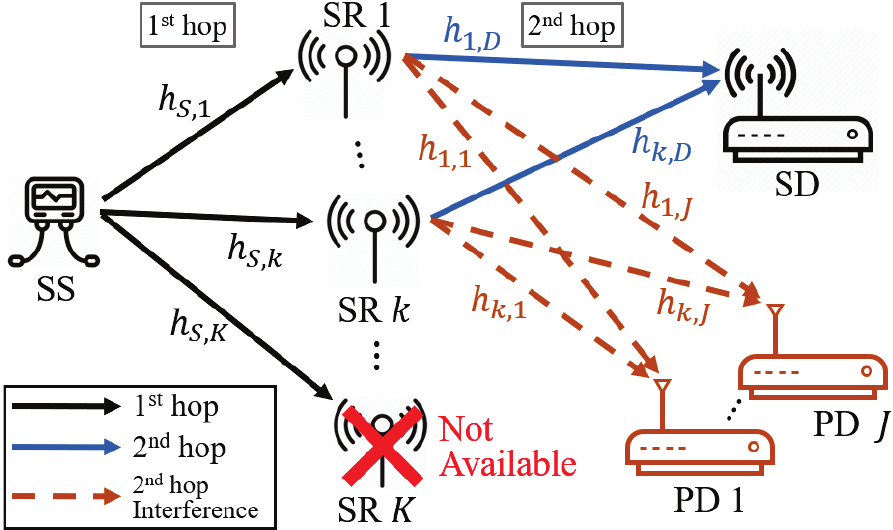
Figure 1. System model of a spectrum sharing-based mobile MANET. SR, secondary relay; SS, secondary source; SD, secondary destination; PD, primary